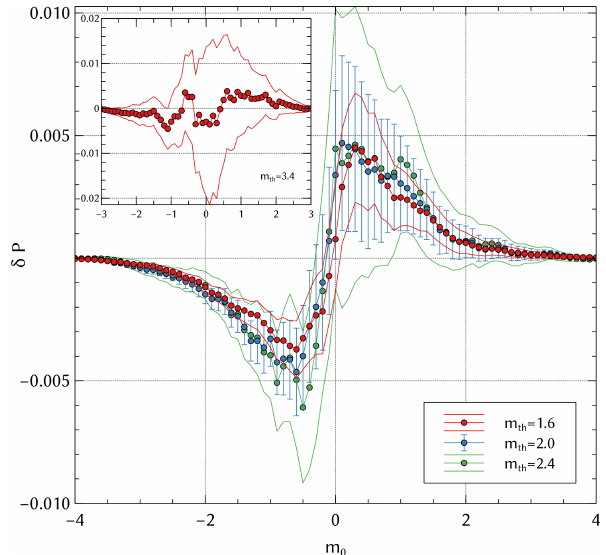
Figure 3. Magnitude correlations of the unconditioned SSAR-SC catalog for m th = 1 . 60, 2.00, 2.40 and 3 . 40 (inset). Error bars cor- respond to 3 σ